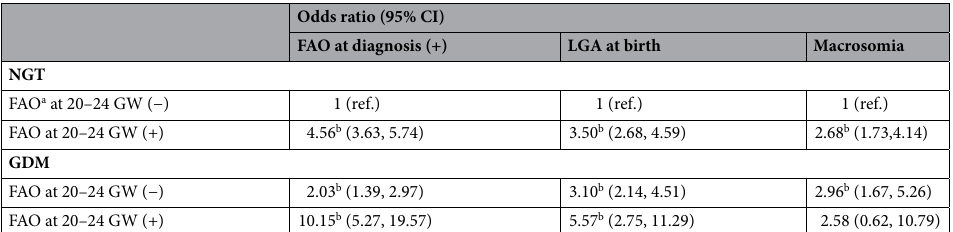
Table 5. Odds ratios of FAO at the time of diagnosis of GDM, LGA at birth, and macrosomia by NGT and GDM subjects and by presence or absence of FAO at 20–24 GW. FAO fetal abdominal obesity, GDM gestational diabetes mellitus, LGA large for gestational age, GW gestational weeks, NGT normal glucose tolerance. a Fetal abdominal obesity defined as fetal abdominal overgrowth ratio ≥ 90th, b p < 0.05 compared with NGT FAO (−).